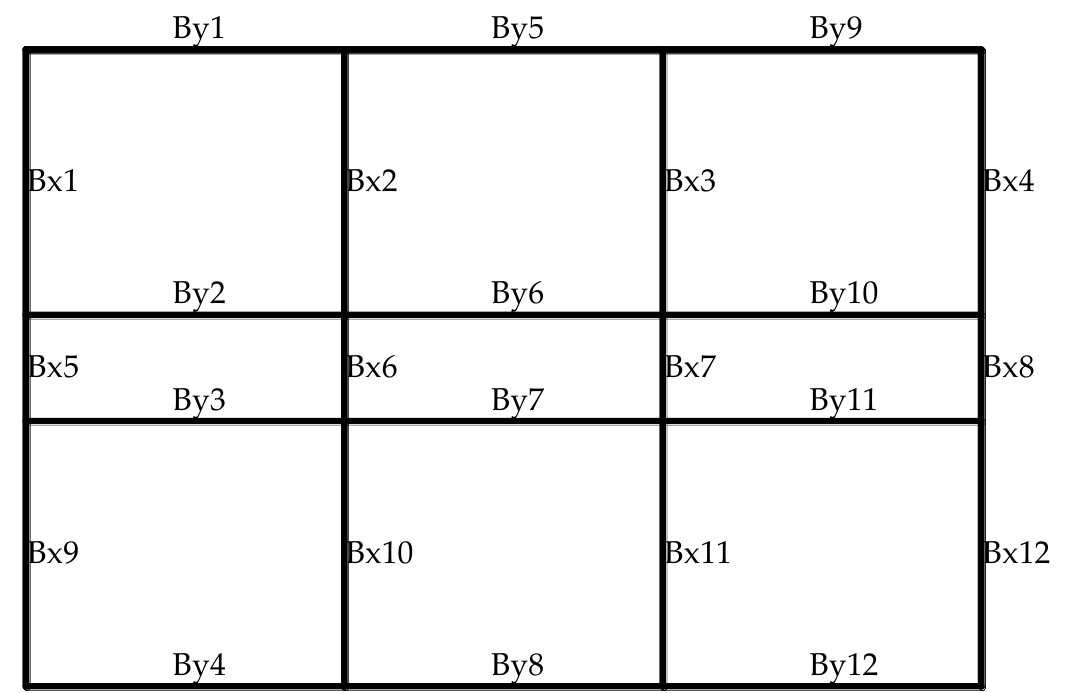
Figure 1. The plan and elevation of the RC frame (unit: mm): ( a ) plan view; ( b ) elevation. Table 2. Sizes and reinforcement details of frame beams.